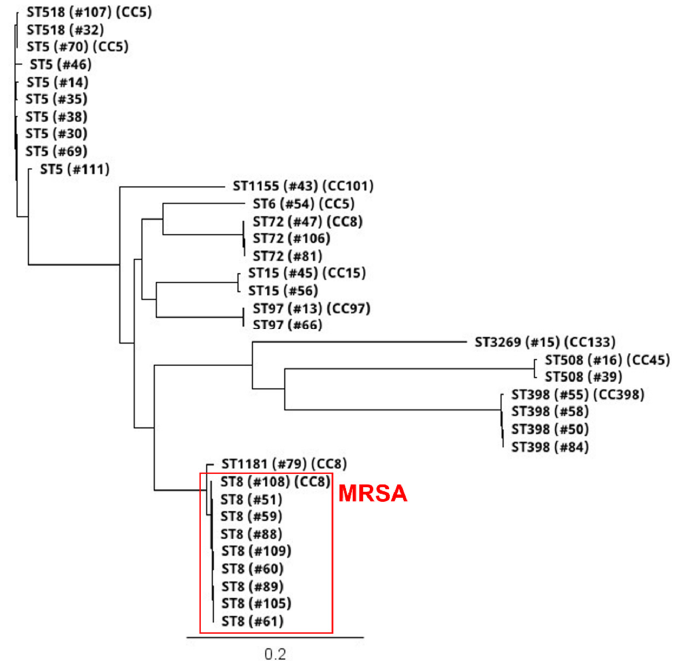
Figure 3. Core genome single nucleotide polymorphism (SNP)-based phylogenetic tree of 12 STs and eight CCs of 36 [nine MRSA, 27 MSSA] isolates collected from coastal beach and river waters, anchialine pools, and sand on Hawai ʻ i Island, Hawai ʻ i, from July to December 2020. The scale bar denotes genetic distance in number of base substitutions per site. Branch tree labels indicate ST, isolate #, and CC.